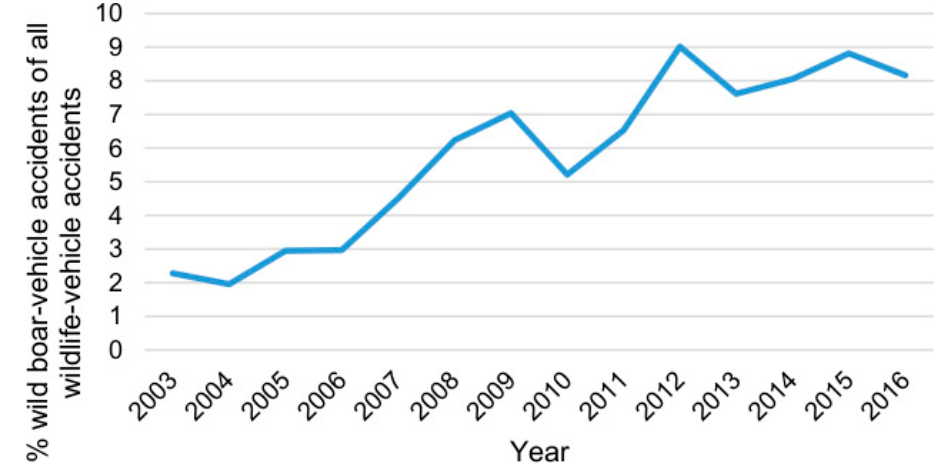
Figure 2. Percentage of wild boar-vehicle accidents of all wildlife-vehicle accidents in Sweden between 2003–2016. The data comes from NVR. 2003–2016. The data comes from